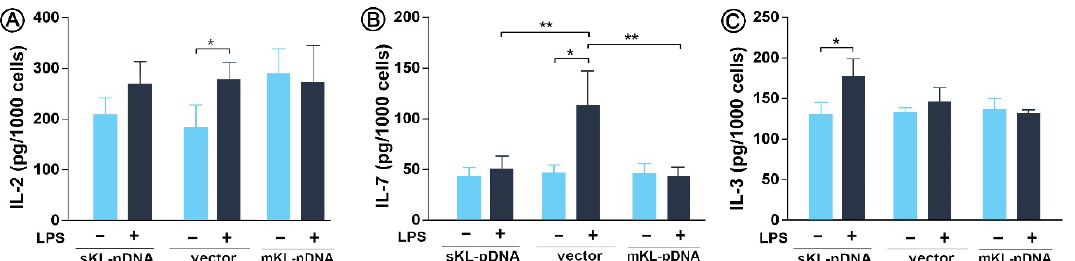
Figure 6. Levels of proinflammatory cytokines. Klotho expression was upregulated with pDNA, cells were treated for 72 h with monensin sodium or 168 h with LPS and secretion of IL-2 ( A ), IL-7 ( B ), and IL-3 ( C ) was evaluated with ELISA method. Bars indicate SD, n = 3, ** p < 0.01, * p < 0.05, no indication – no statistical significance (one-way ANOVA and Dunnett’s a posteriori test).